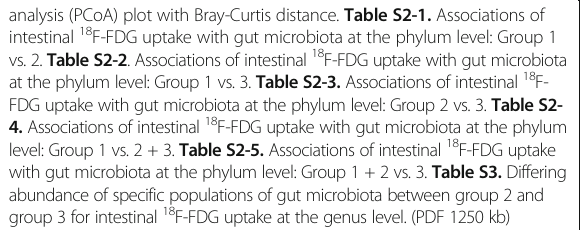
Additional file 1: Figure S1. Comparisons of community alpha diversities among groups for the intestinal 18 F-FDG. Table S1. Association between alpha diversity and intestinal 18 F-FDG uptake. Figure S2. Principal coordinate